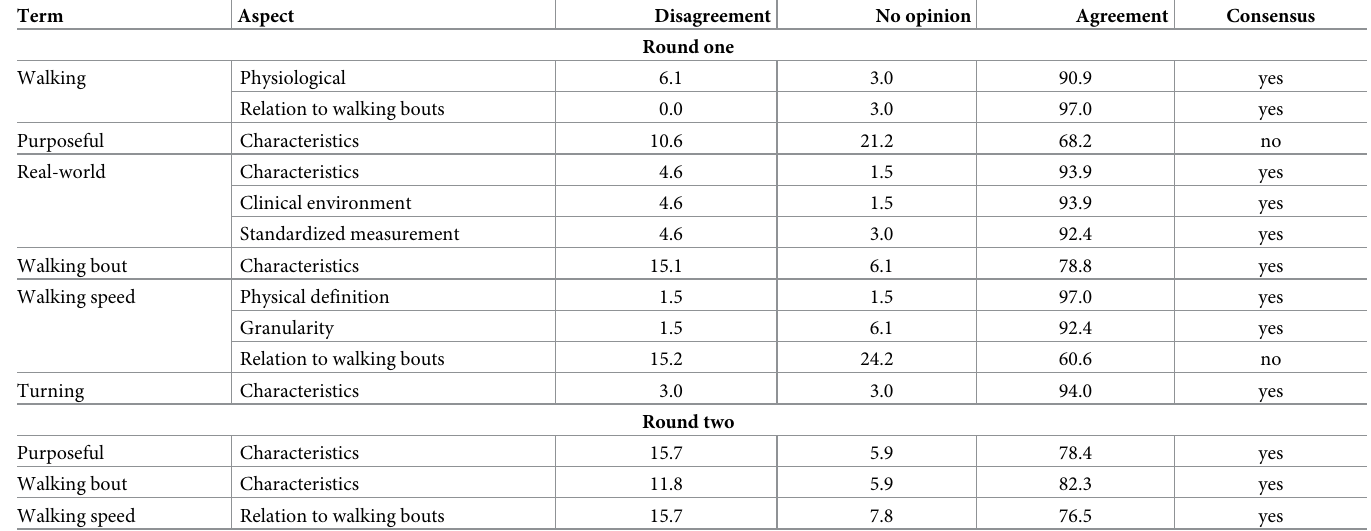
Table 3. Proportion of agreement and disagreement [%] of definitions. In round two, only those definitions were evaluated, which did not reach agreement in the first round. The lower limit of agreement was a priori defined as